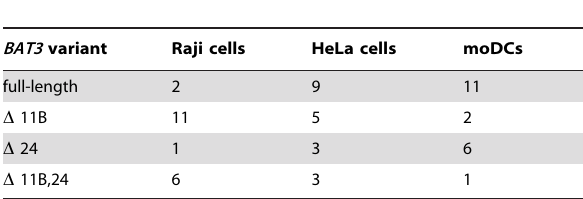
Table 2. Subcellular localization of endogenous BAT3 in % of cells. Table 3. Tissue specific expression of BAT3 splice